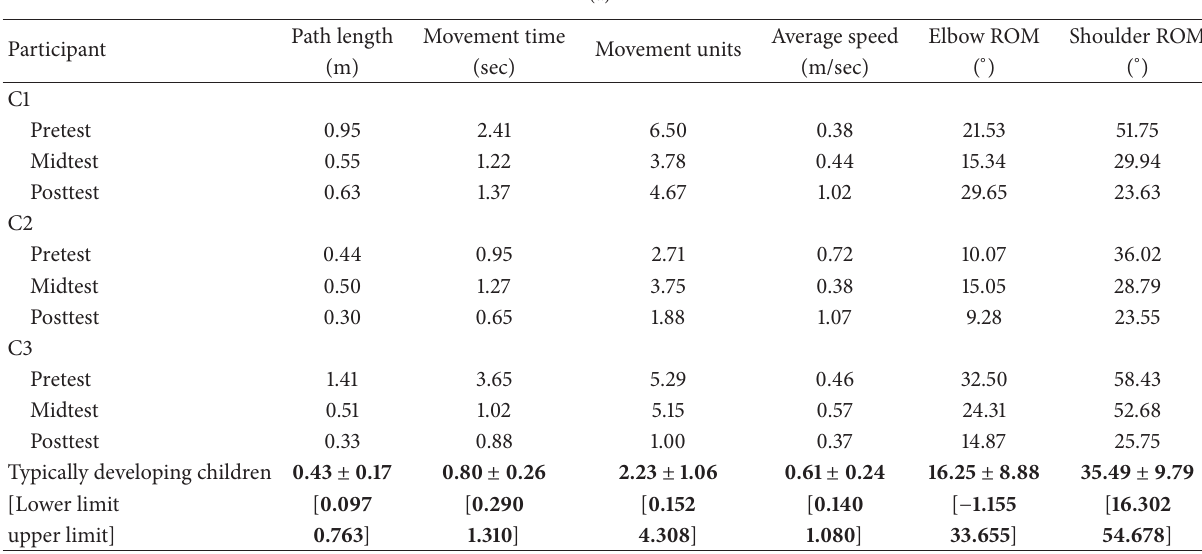
Table 2: (a) Kinematic variables of the more affected hand (nonpreferred hand) in children with and without CP. (b) 𝑧 scores of the more affected hand (nonpreferred hand) in children with